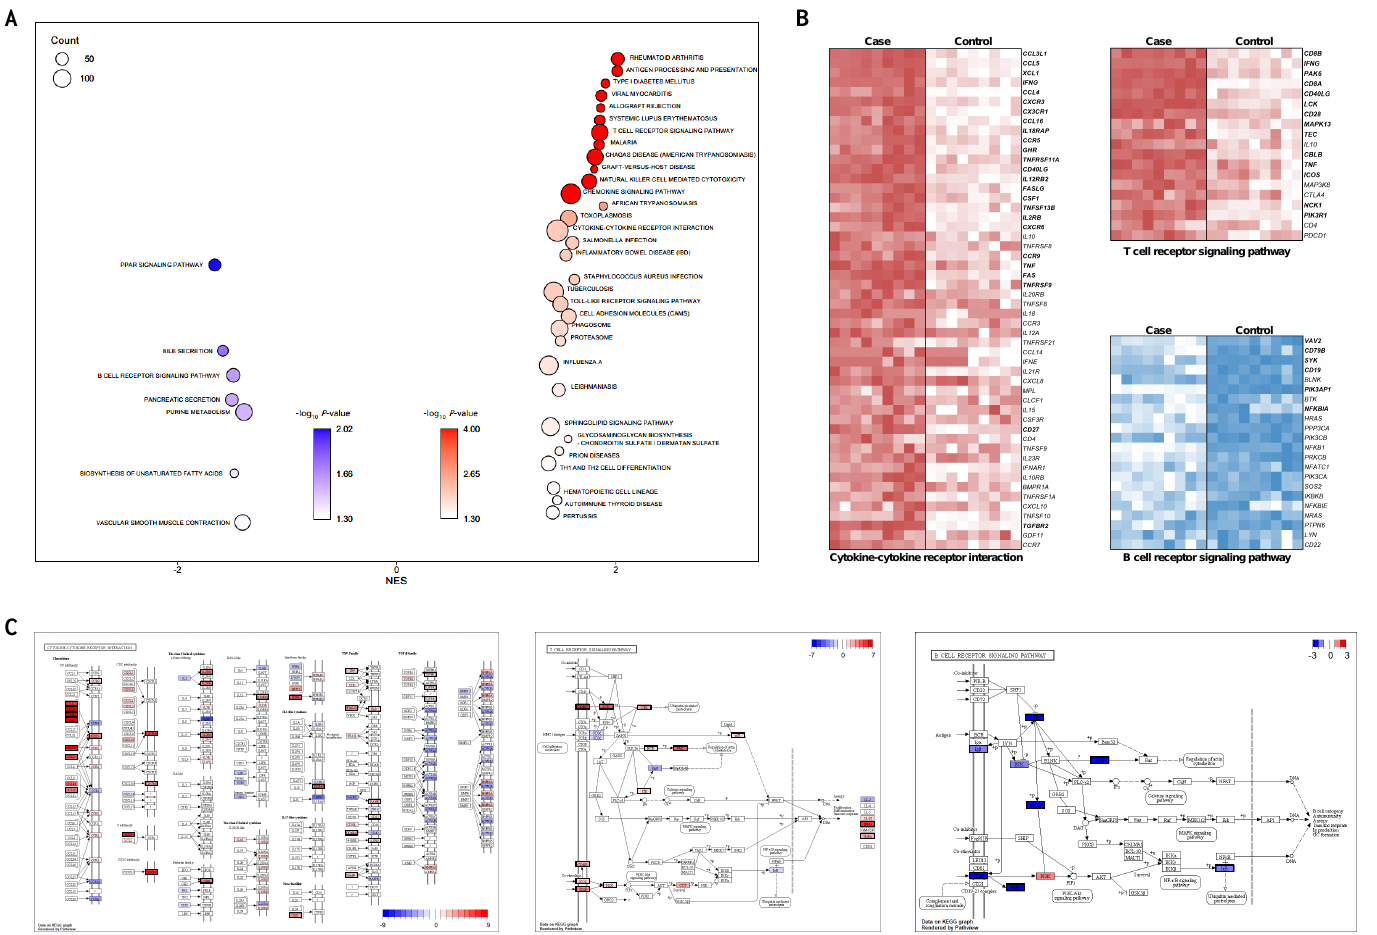
Figure 3. Visualized GSEA results related to three main pathways: ( A ) bubble plot for GSEA showed KEGG-enriched terms; ( B ) heatmaps for core enriched genes in three main pathways (T cell receptor signaling pathway, B cell receptor signaling pathway, and cytokine–cytokine receptor interaction) are shown. The genes in bold include common DEGs between case 1 and 2. ( C ) Pathway profiling for three main pathways were visualized with both significant genes in DEGs and GSEA. Proteins corresponding to genes are presented as log 2 FC values and significant genes are shown with a black